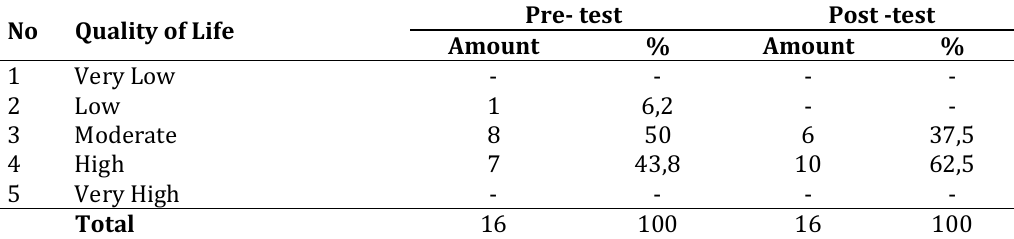
Quality of Life Level in the Control